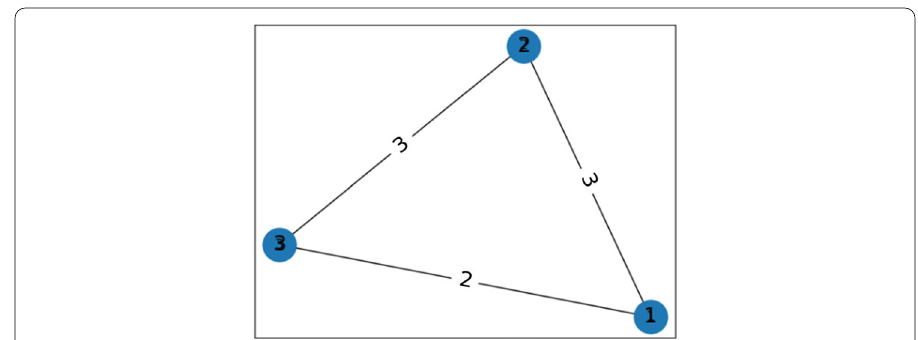
Fig. 2 Item association graph partition 1